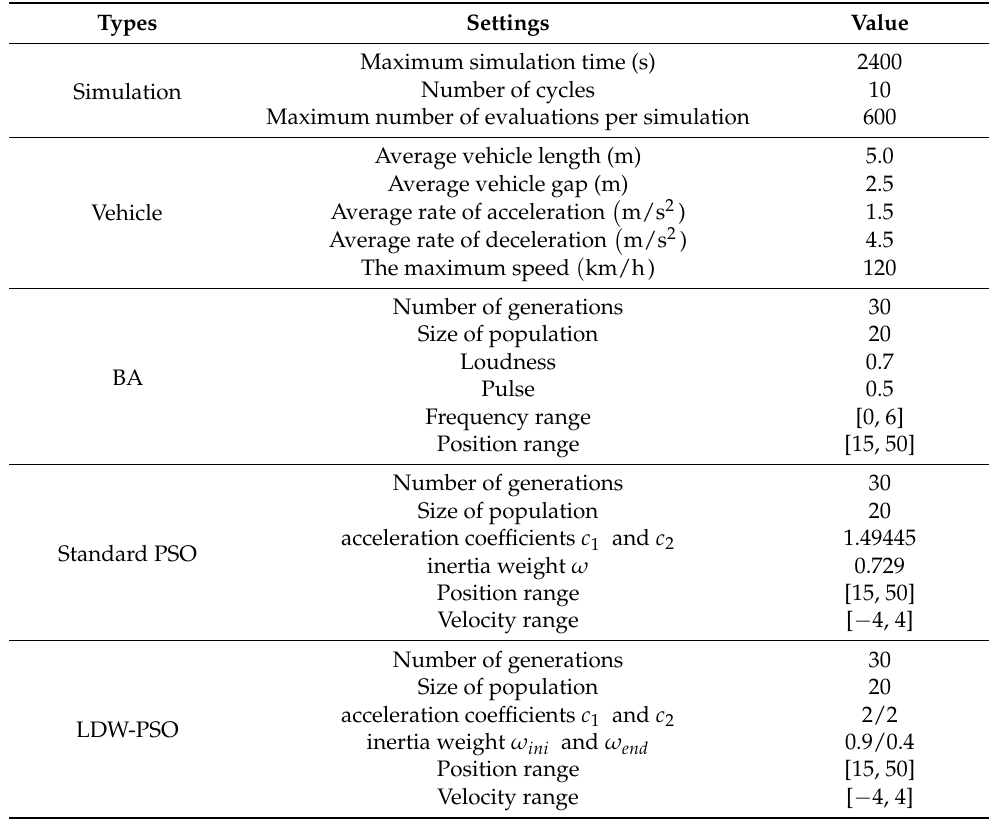
Table 4. Simulation, Vehicle, B.A., standard PSO, and